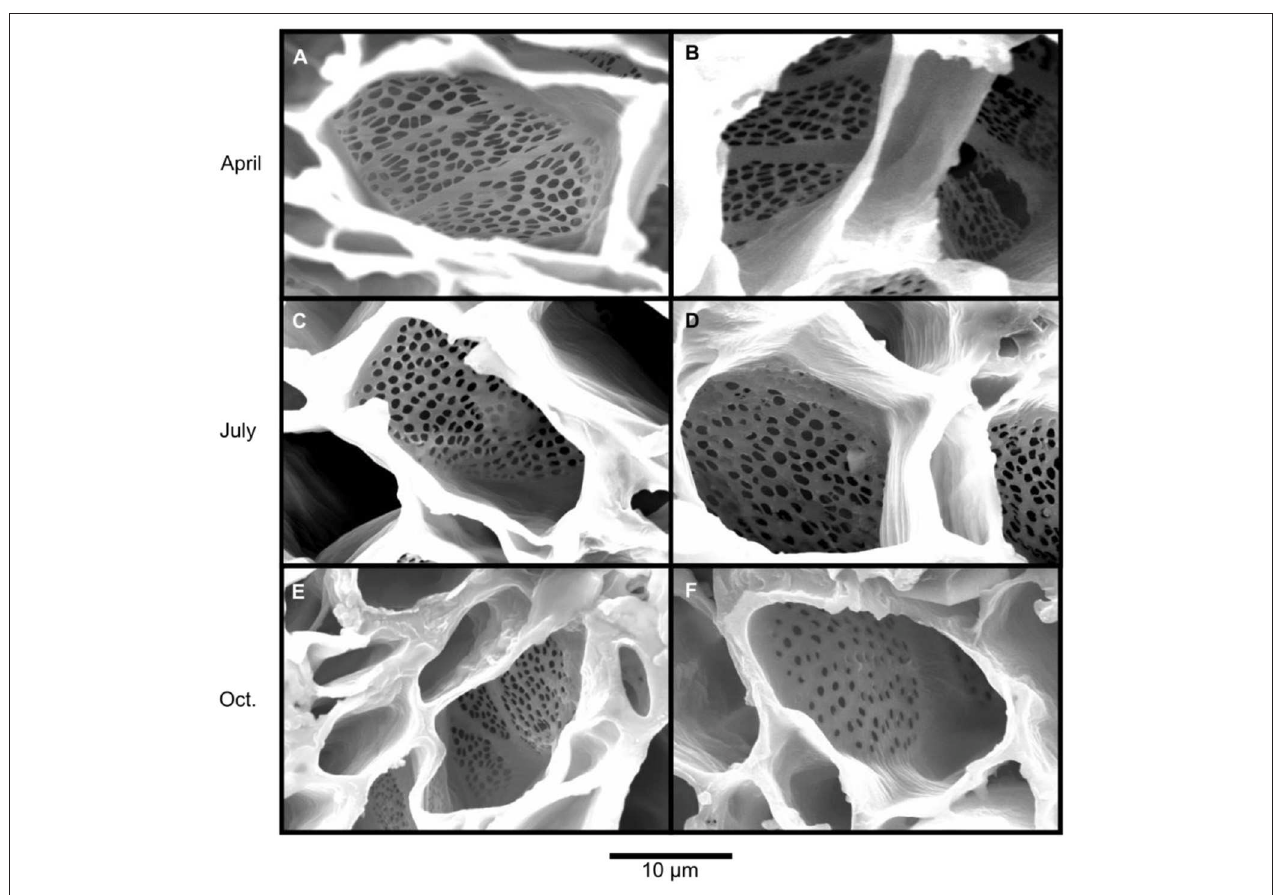
FIGURE 4 | Scanning electron microscopy images showing the state of sieve plates in balsam poplar throughout the year. Samples were collected prior to the start of the growing season in April (A,B) , at the peak of the growing season in July (C,D) and after the end of the growing season in October (E,F) . In April and July, there was no or little callose deposition and pores were open. Samples collected in October had experienced several freeze-thaw cycles (minimum temperature: − 5 ◦ C). Nonetheless, only two out of 21 observed plates in early phloem and 6 out of 23 observed plates in late phloem showed appreciable callose deposition; an example for plates with partially blocked pores is shown in F. Callose deposition will decrease translocation rates because the size and shape of the pores in sieve plates is highly influential for phloem transport